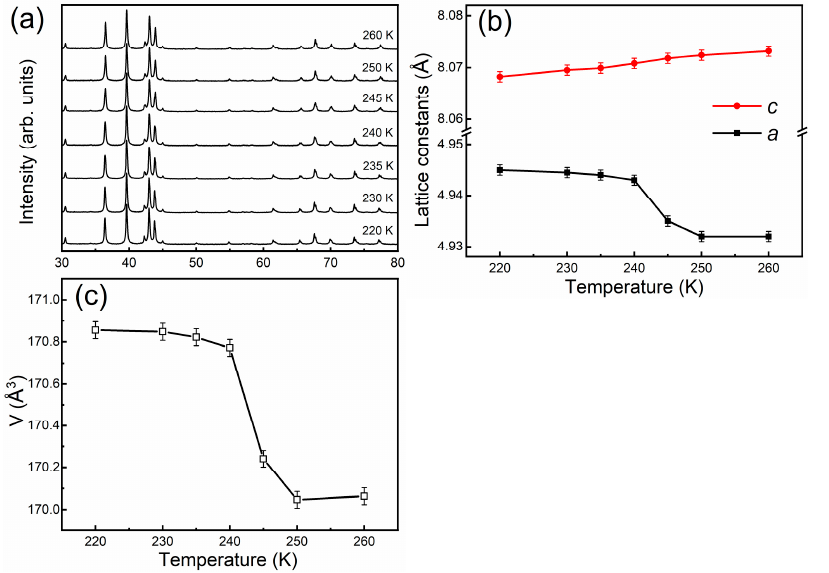
Figure 5. ( a ) Temperature dependent XRD patterns for the Hf 0.84 Ta 0.16 Fe 2 alloy; ( b ) Change of lattice parameters a and c as a function of temperature; ( c ) Temperature dependence of unit cell volume.